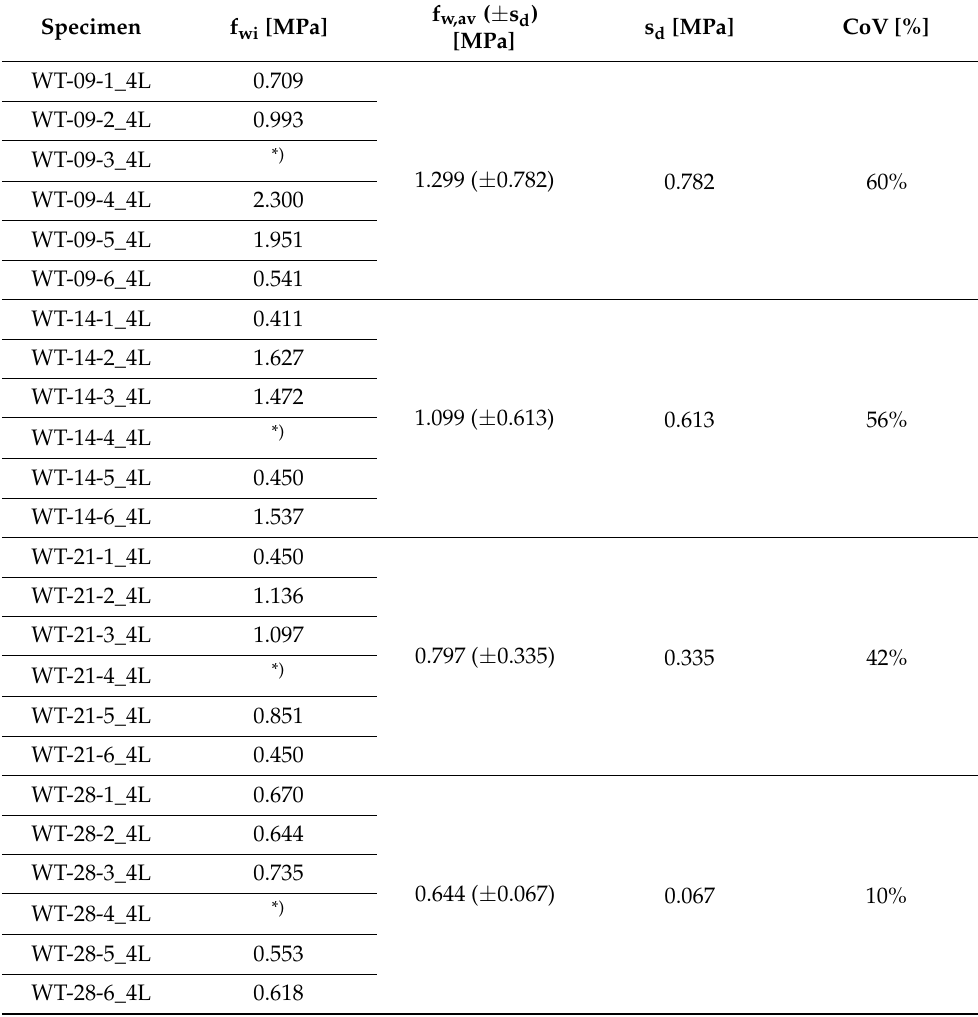
Table 4. Bond strength results for series using 4 L of mixing water.